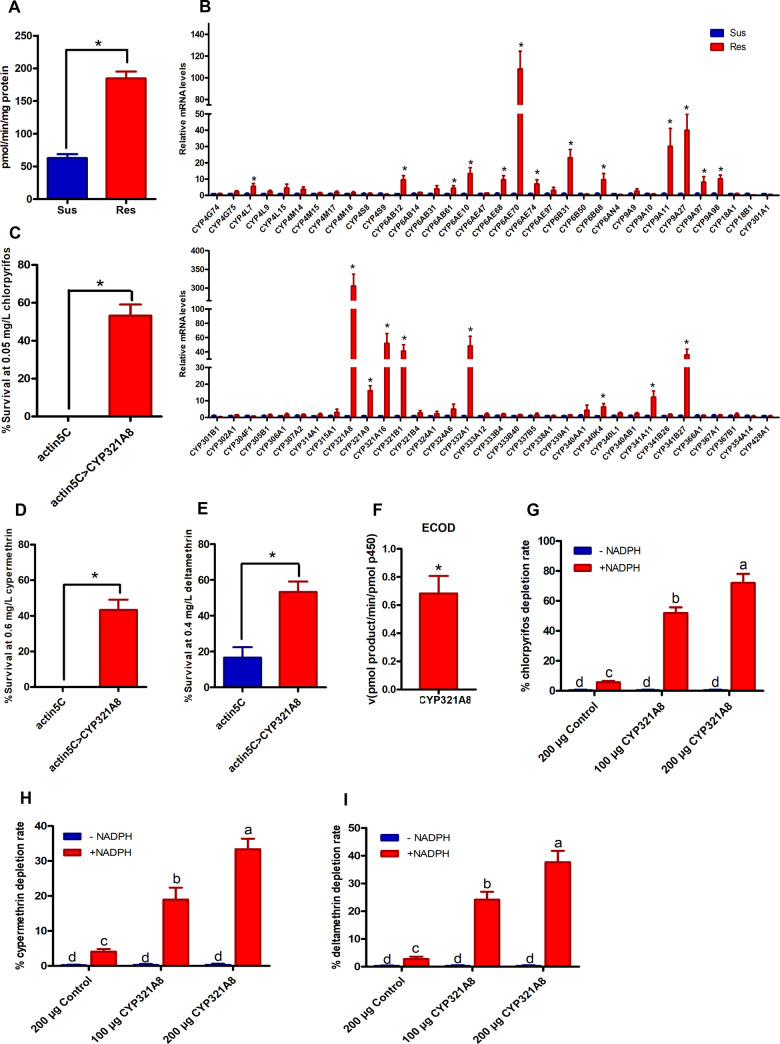
Overexpression of CYP321A8 confers resistance to multiple insecticides in S. exigua.(A) P450 activity in the larvae of the susceptible and resistant strains of S. exigua. P450 monooxygenase activity was evaluated by measuring ethoxycoumarin-O-deethylase (ECOD) activity. A significant difference in enzymatic activities is indicated using an asterisk (Student’s t-test, p < 0.05). Error bars indicate SD. (B) Relative expression of P450 genes in the susceptible and resistant strains of S. exigua as determined by RT-qPCR. Error bars display SD. A significant difference in expression between the susceptible and resistant strains is indicated using an asterisk (ANOVA with post-hoc Tukey’s HSD, p < 0.05). The sensitivity of transgenic D. melanogaster to chlorpyrifos (C), cypermethrin (D) and deltamethrin (E). Error bars display SD. Significant differences in mortality between lines expressing CYP321A8 and control flies without the transgene are indicated using an asterisk (Student’s t-test, p < 0.05). (F) Metabolic activity of recombinant CYP321A8 enzyme against a model fluorescent substrate. The rate of O-dealkylation of 7-ethoxy coumarin (ECOD) is shown. Error bars display SD. Metabolism of chlorpyrifos (G), cypermethrin (H) and deltamethrin (I) metabolism by recombinant CYP321A8. Error bars display SD values. Significant differences (p < 0.05) in metabolism are denoted using letters above bars (ANOVA with post-hoc Tukey’s HSD).